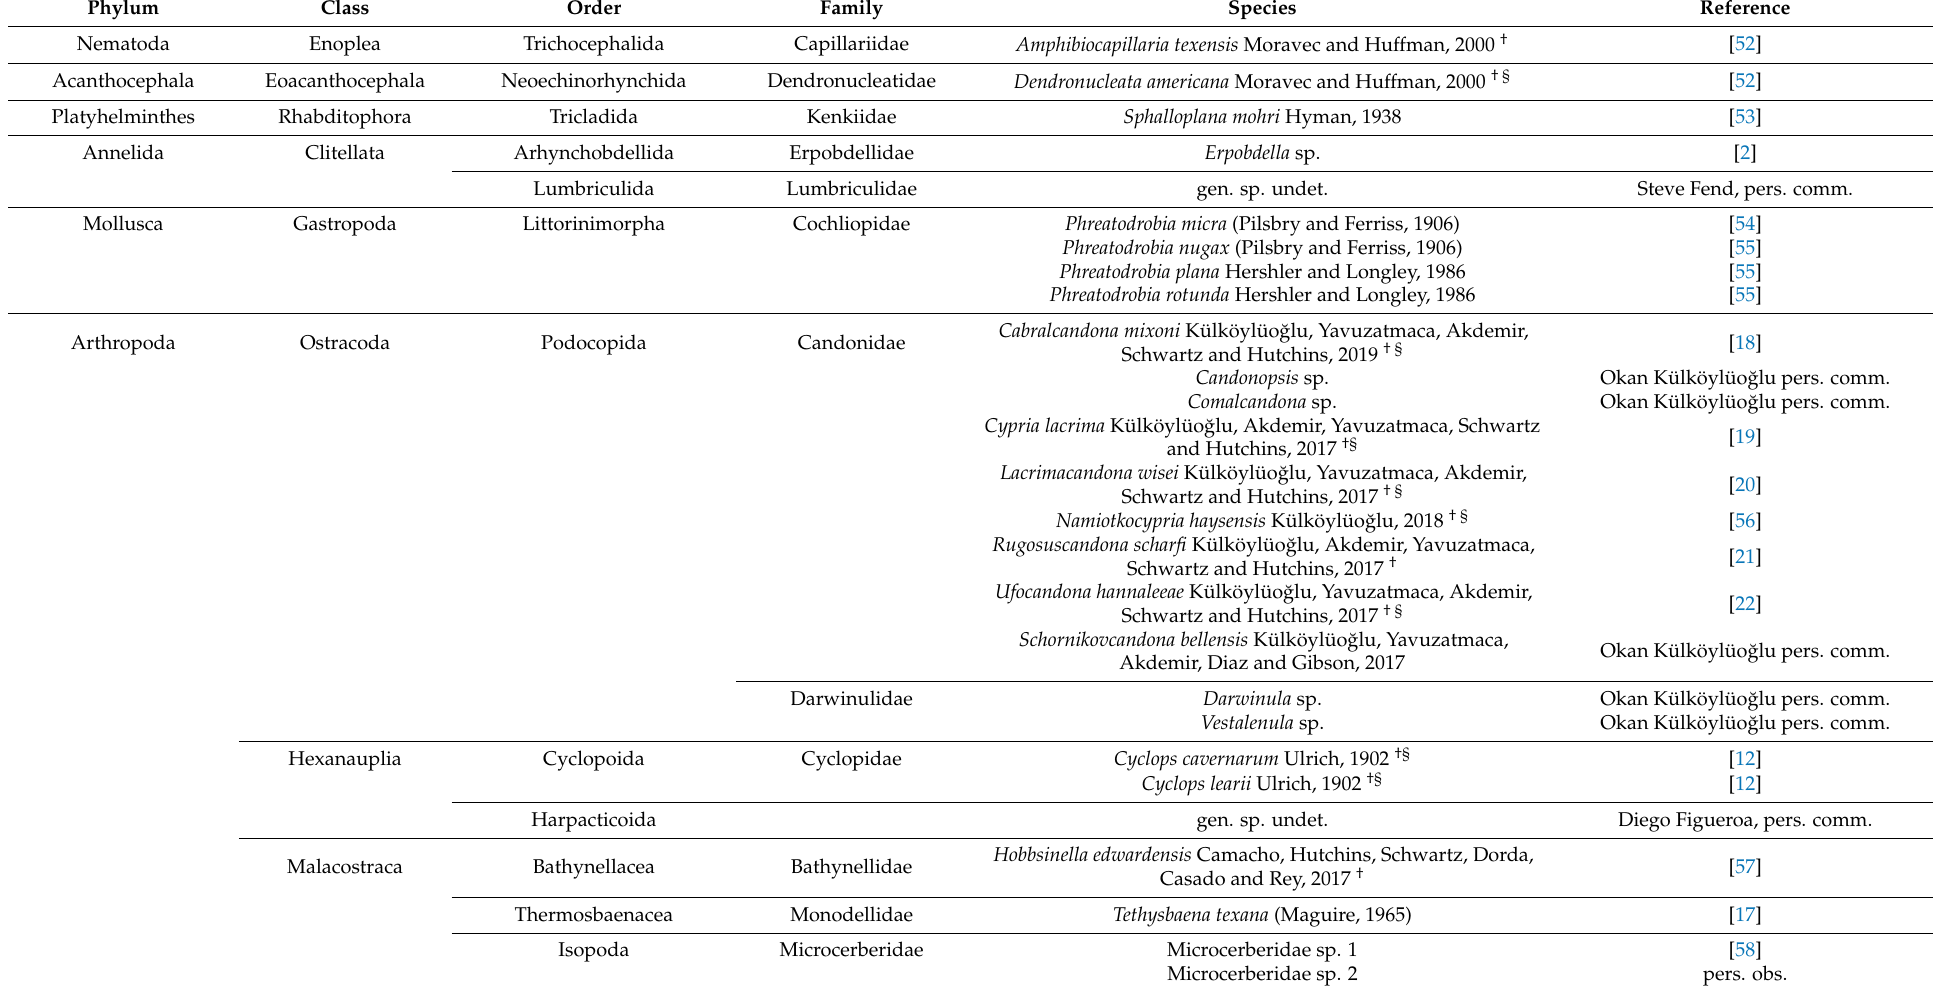
Table 1. Stygobionts from the San Marcos Artesian Well and basis of record. § = single site endemic; † = type